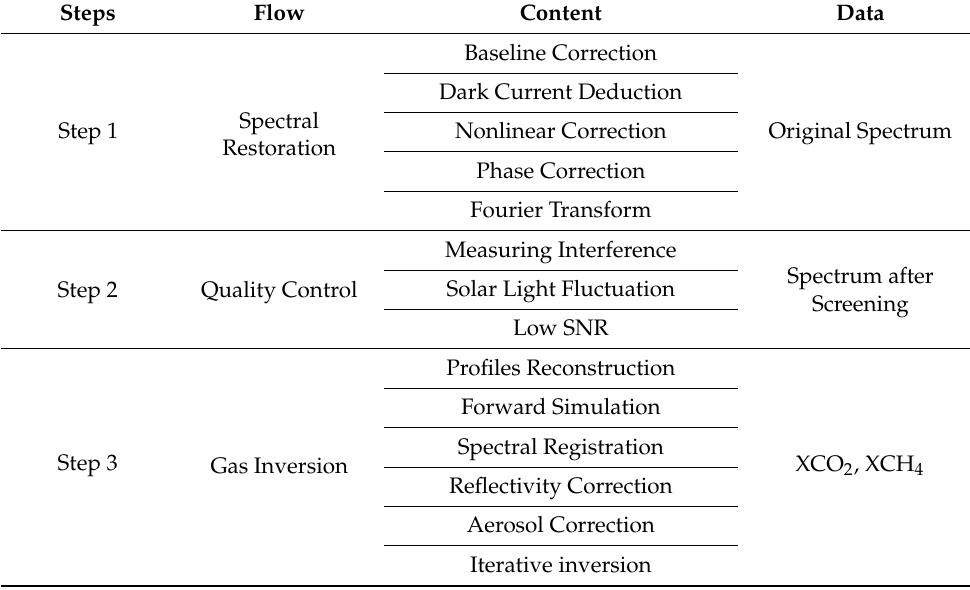
Figure 11. Flow Chart of Greenhouse Gas Retrieval. Table 2. Data processing and correction steps of HRFTS.